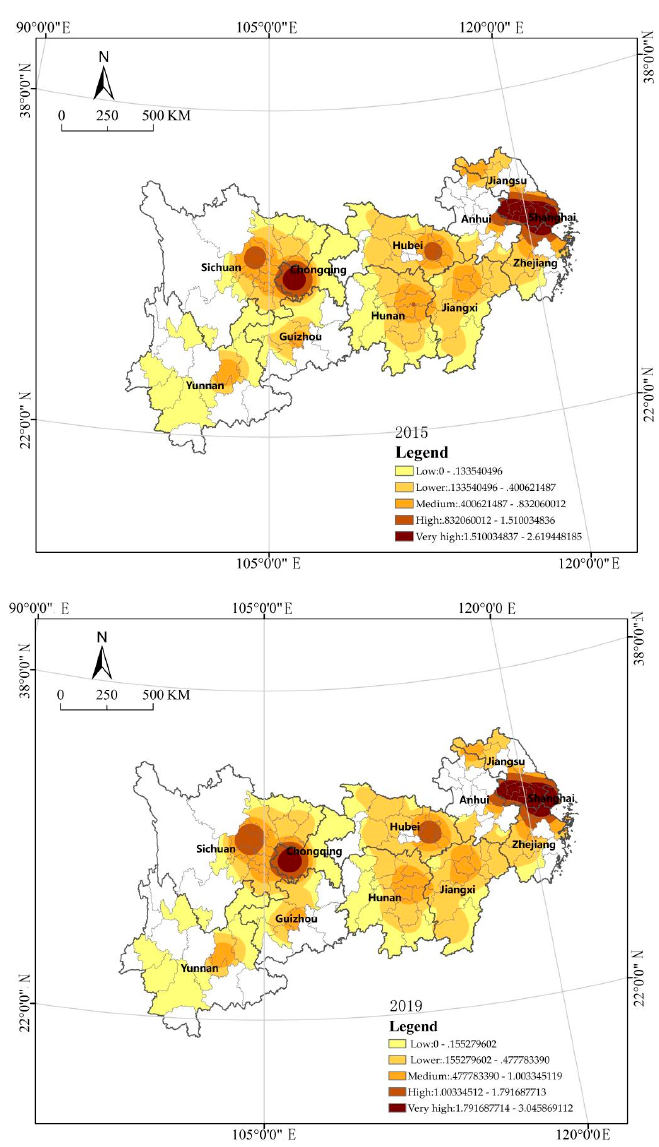
Figure 3. Kernel density analysis of the urban green area ( 2015–2019 ) .